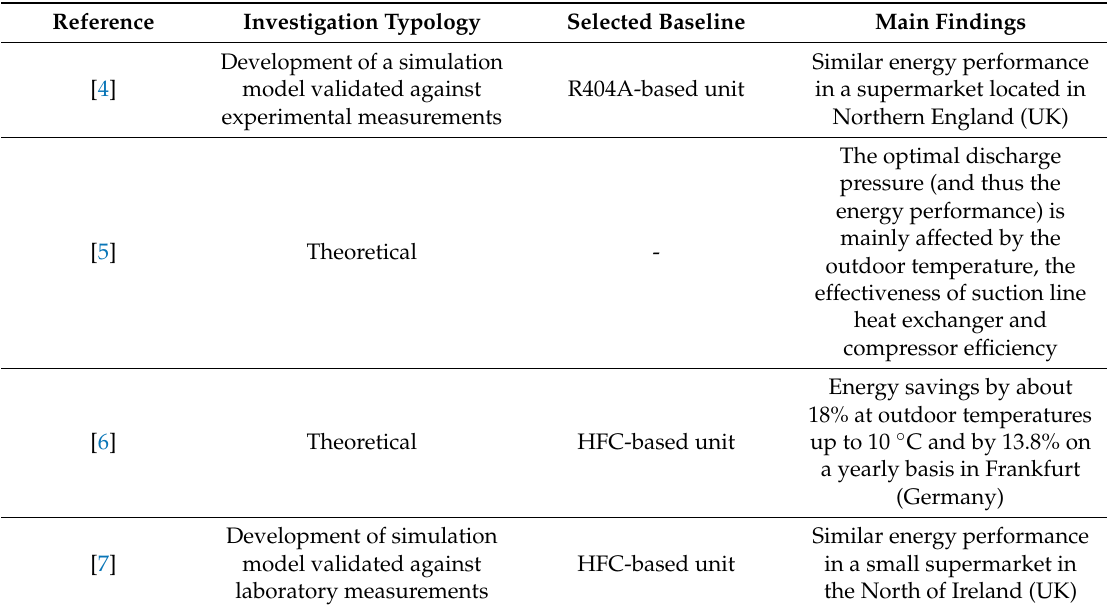
Table 1. Findings of the main investigations associated with conventional “CO 2 -only” booster supermarket refrigeration